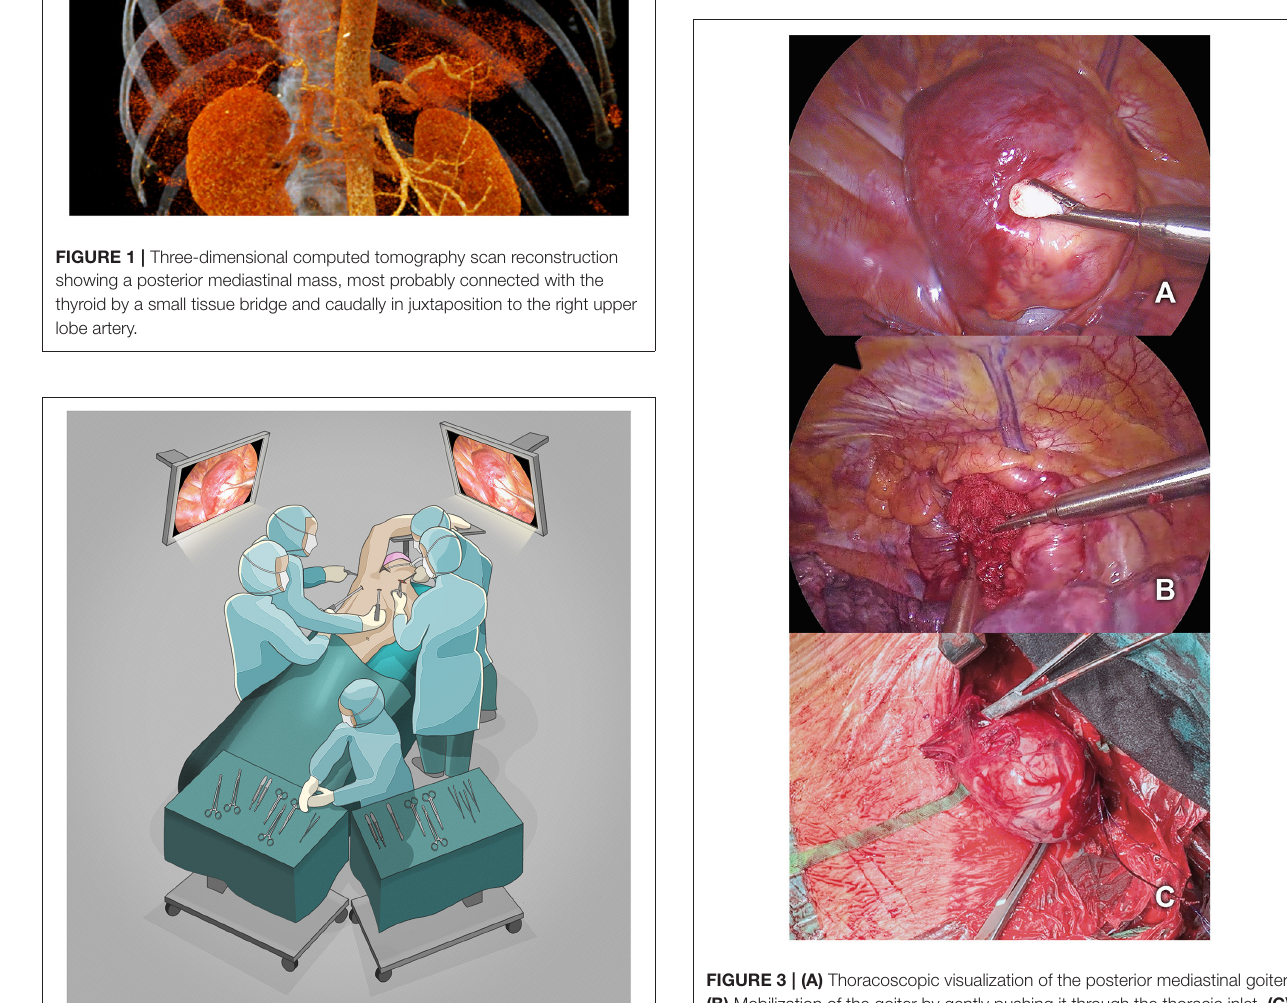
FIGURE 2 | Two-team approach surgical scenario setting.